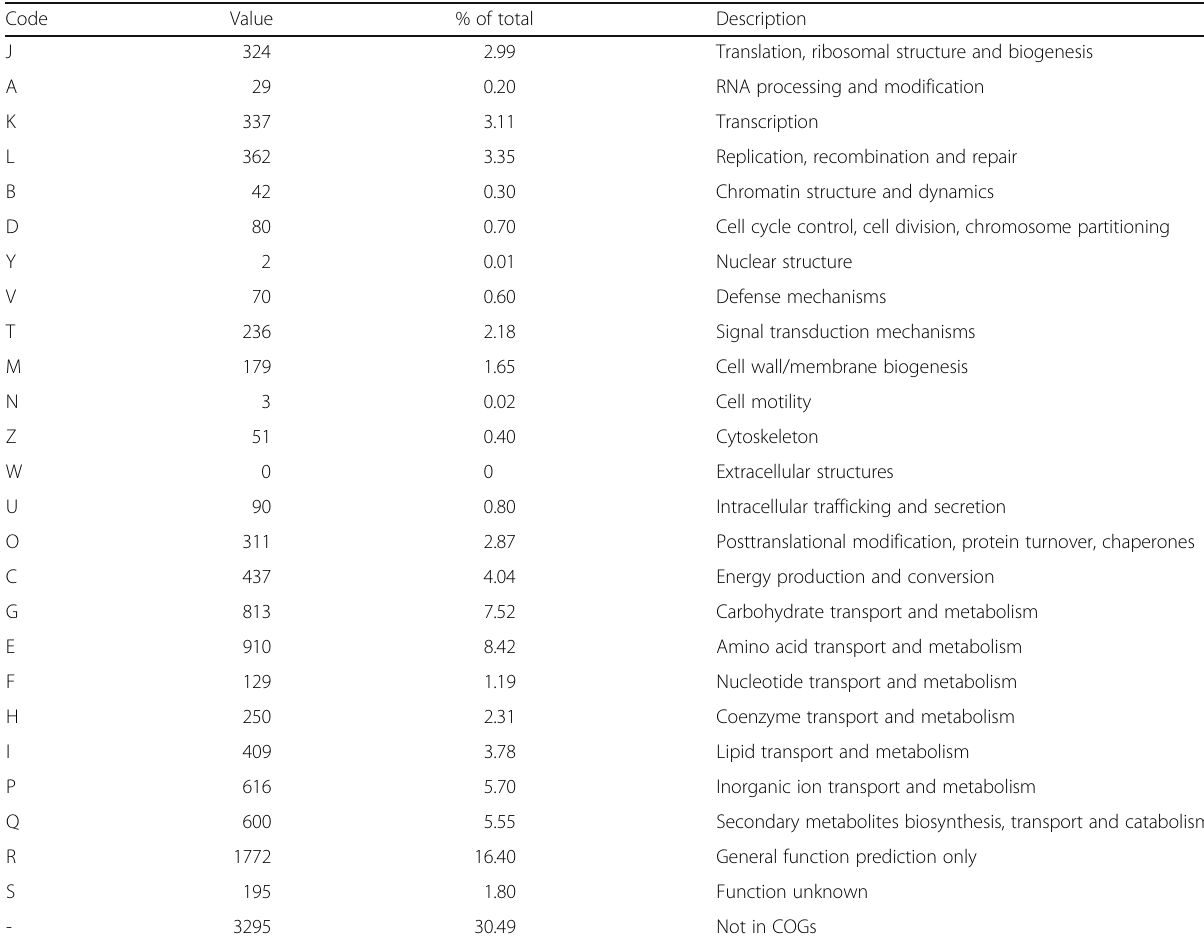
Table 4 Number of genes associated with general COG functional